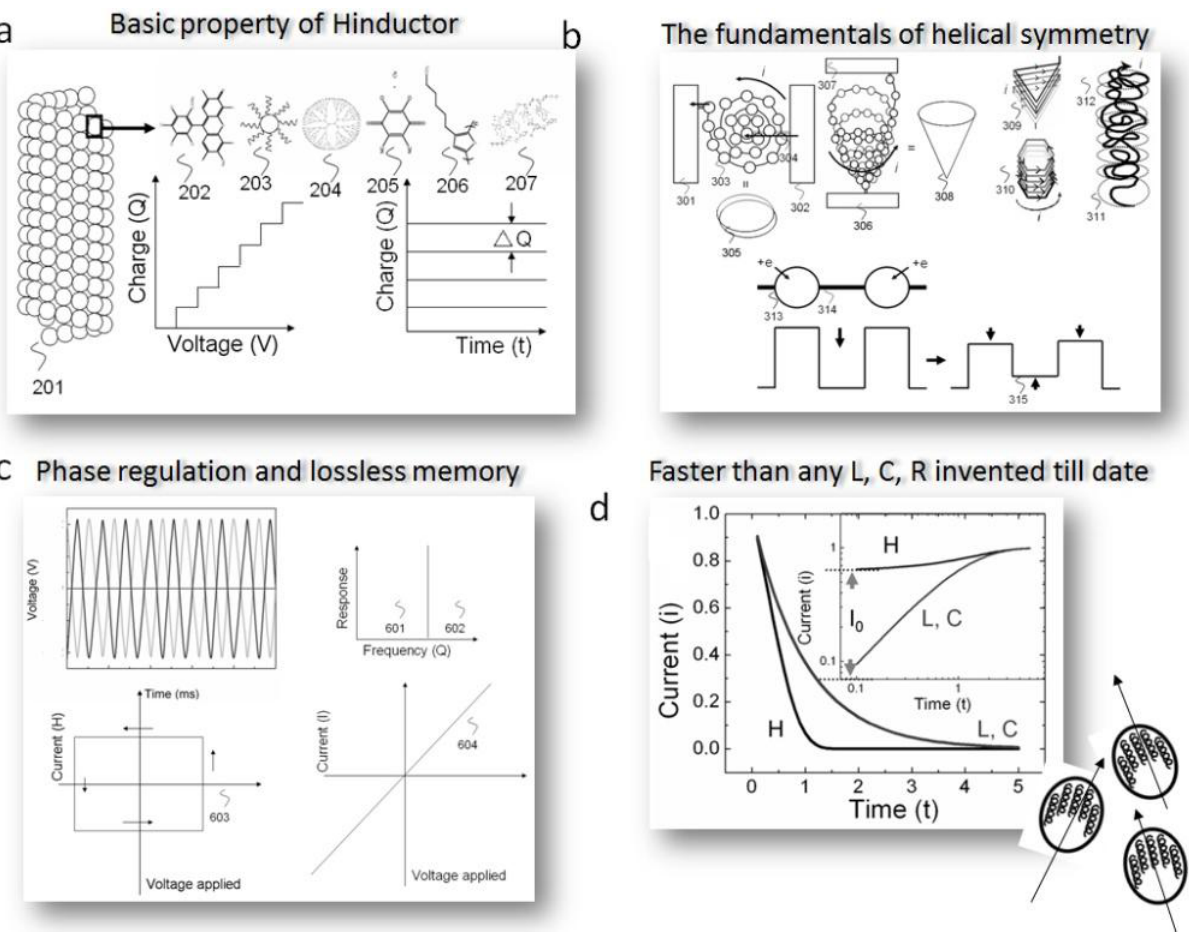
Figure 23. ( a ) Hinductor is organic, or inorganic or mixture of organic and inorganic materials helical device, the same way charge increases with voltage, the magnetic flux also increases; ( b ) The helical symmetry does not always mean tube-like structures, here several alternate helical symmetries in 2D and 3D planes are shown; ( c ) 180° out of phase signal production by Hinductor device (top-left), threshold operational frequency (top-right), Hinductor has upper and lower frequency limits of operation, lossless perfect square current voltage features (bottom left), current voltage under ac (bottom-right); ( d ) Temporal response of a Hinductor device, H = Hinductor, it is compared with a conventional L and C